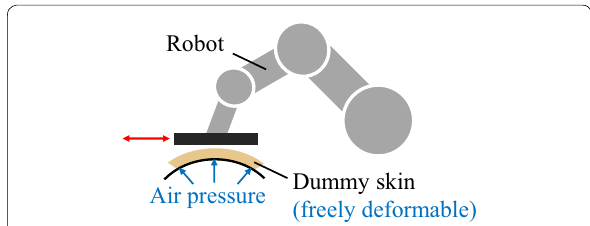
Dummy skin Air (freely deformable) Fig. 2 Safety test with variable shape dummy